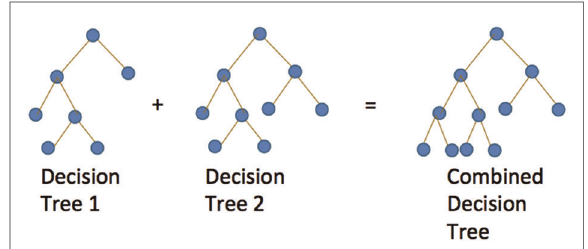
FIGURE 1 Graphical illustration of tree-based algorithms such as random forests and XGBoost. Both algorithms build multiple trees for prediction. Random forests build independent trees whereas XGBoost builds trees based on the performance of previous trees.